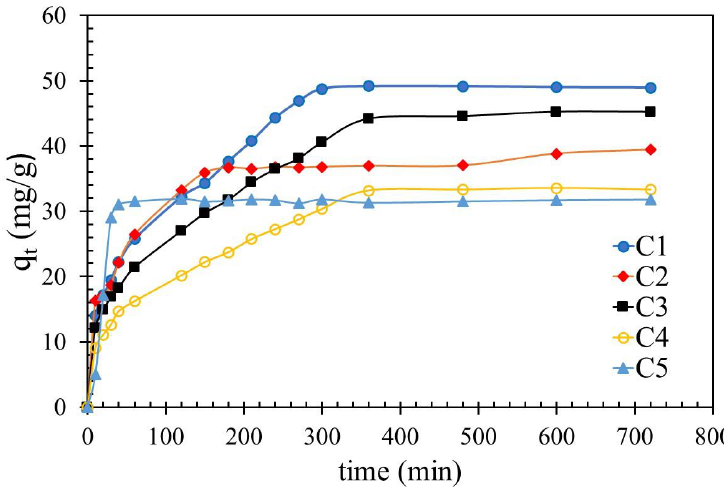
Figure 8. Effect of contact time on Pb (II) adsorption onto clays in the study; agitation speed (130 rpm), temperature (25 °C), pH 6 and initial adsorbate concentration (300 mg/L).